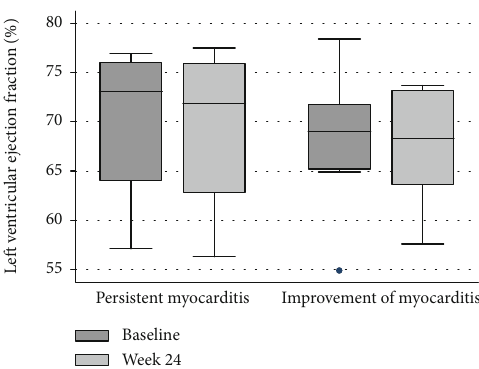
1 Comparison of clinical characteristics at baseline between those with SSc who had improvement of myocarditis vs. persistent myocarditis. 2 Comparison of clinical characteristics at week 24 between those with SSc who had improvement of myocarditis vs. persistent myocarditis. CK-MB denotes creatine kinase- muscle/brain; CMR: cardiovascular magnetic resonance; hs-cTnT: high sensitivity of cardiac Troponin-T; HRCT: high-resolution computed tomography; LV: left ventricular; NT-proBNP: NT-prohormone-brain natriuretic peptide; NYHA: New York Heart Association; RV: right ventricular; SD: standard deviation; SSc: systemic